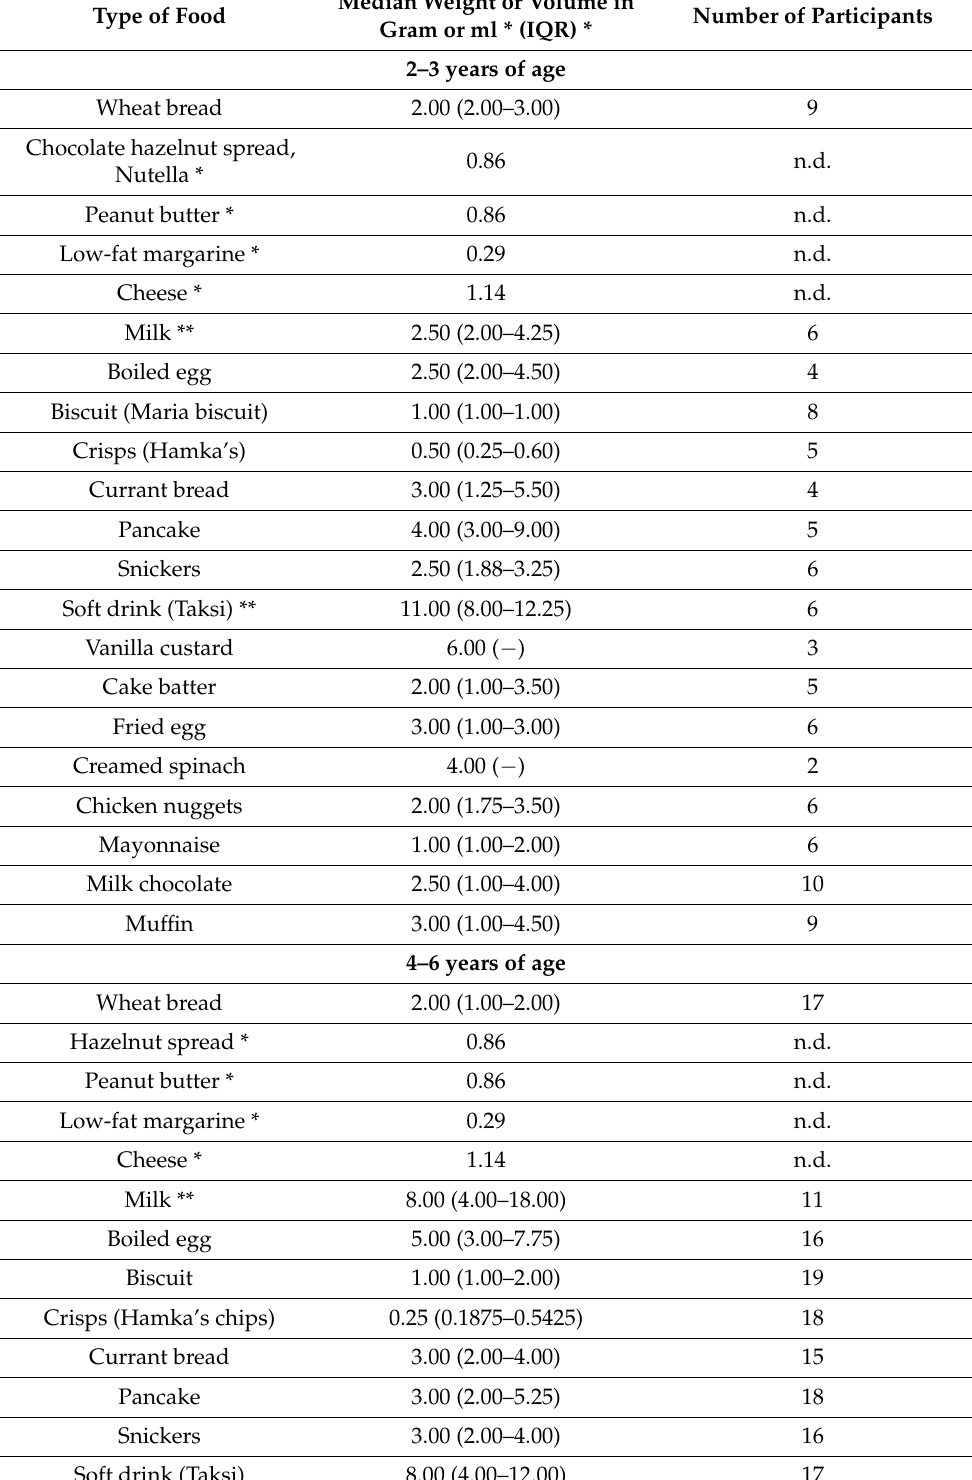
Table 3. Median (IQR) bite and sip sizes in different age groups in grams or milliliters. Type of